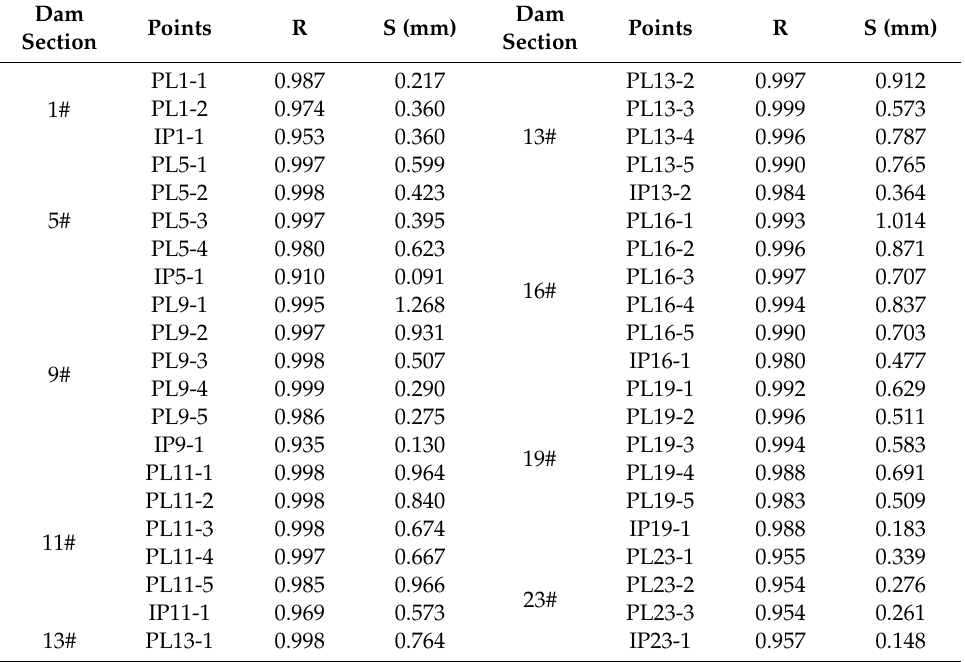
Figure 16. Fitting curve between hydraulic component displacement calculated by FEM of PL13-2 and water level. Table 7. Correlation coe ffi cient and residual standard deviation of deformation hybrid model of typical measuring